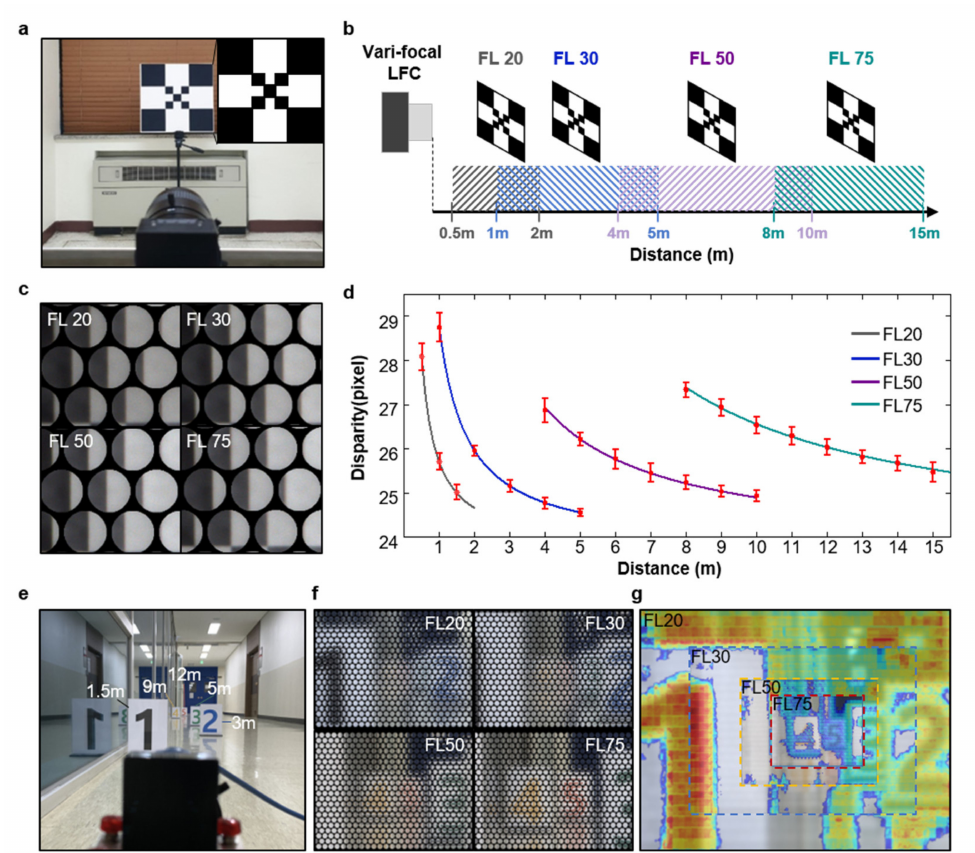
Figure 4. ( a ) Photograph of the VF-LFC and reference image (inset). ( b ) Schematic of VF-LFC experimental setup according to the measurement regions for each focal length. ( c ) Micro-images from VF-LFC at four different focal lengths. ( d ) Graph of the disparity according to object distance, solid lines are calibrated result and red dots represent experimental result. ( e ) Photograph of sequential depth measurement setup with the VF-LFC. ( f ) Micro-images from VF-LFC at four different focal lengths. ( g ) Stitched image with four different focal length photographs, overlapped by normalized disparity